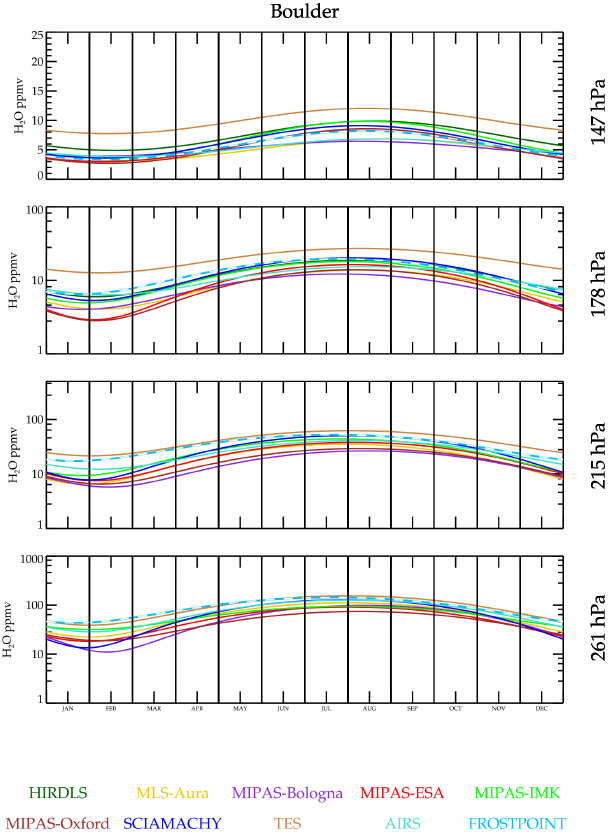
Figure 12. Same as Fig. 9 but for Hilo,